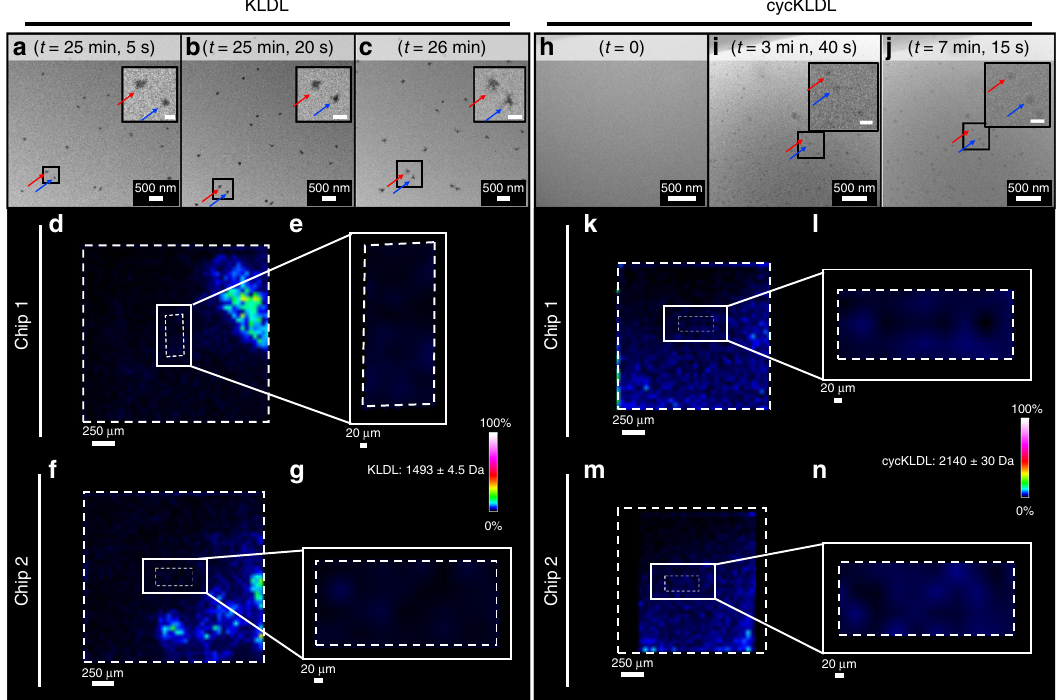
Fig. 5 LCTEM of KLDL and cycKLDL under high fl ux conditions and post-mortem MALDI-IMS analysis. a – c LCTEM images acquired during irradiation of KLDL solution at high fl ux (26.6 e − Å − 2 s − 2 ) for 30 min continuously. t = 0 corresponds to the start of imaging in the shown region of the liquid cell. Red and blue arrows distinguish particles tracked during the series of images. Scale bars of insets = 100 nm. d MALDI-IMS mapping of chip 1 from the LCTEM experiment shown in a – c with fi lter (with manually de fi ned range represented as ±) for KLDL applied (1493 ± 4.5 m/z ). Boxes with dashed lines depict regions of interest analyzed by MALDI-IMS (entire chip surface or window only). e Zoom-in of MALDI-IMS mapping of the window region in d with fi lter for KLDL applied (1493 ± 4.5 m/z ). f , g Complimentary analysis as in d , e for chip 2. h – j LCTEM images acquired during irradiation of cycKLDL solution at high fl ux (20.4 e − Å − 2 s − 1 ) for 30 min continuously, during which particle assembly and growth was observed. t = 0 corresponds to the start of imaging in the shown region of the liquid cell. Red and blue arrows in LCTEM micrographs distinguish particles tracked during the series of images. Scale bars of insets = 100 nm. k MALDI-IMS mapping of chip 1 from the LCTEM experiment shown in ( i – k ) with fi lter for KLDL applied (1493 ± 4.5 m/z ). Boxes with dashed lines depict regions of interest analyzed by MALDI-IMS (entire chip surface or window only). l Zoom-in of MALDI-IMS mapping of the window region shown in k with fi lter for KLDL applied (1493 ± 4.5 m/z ). m , n Complimentary analysis as in k , l for chip 2. Filter colors are displayed as 0 – 100% of integrated intensity on a logarithmic scale within the analyzed region